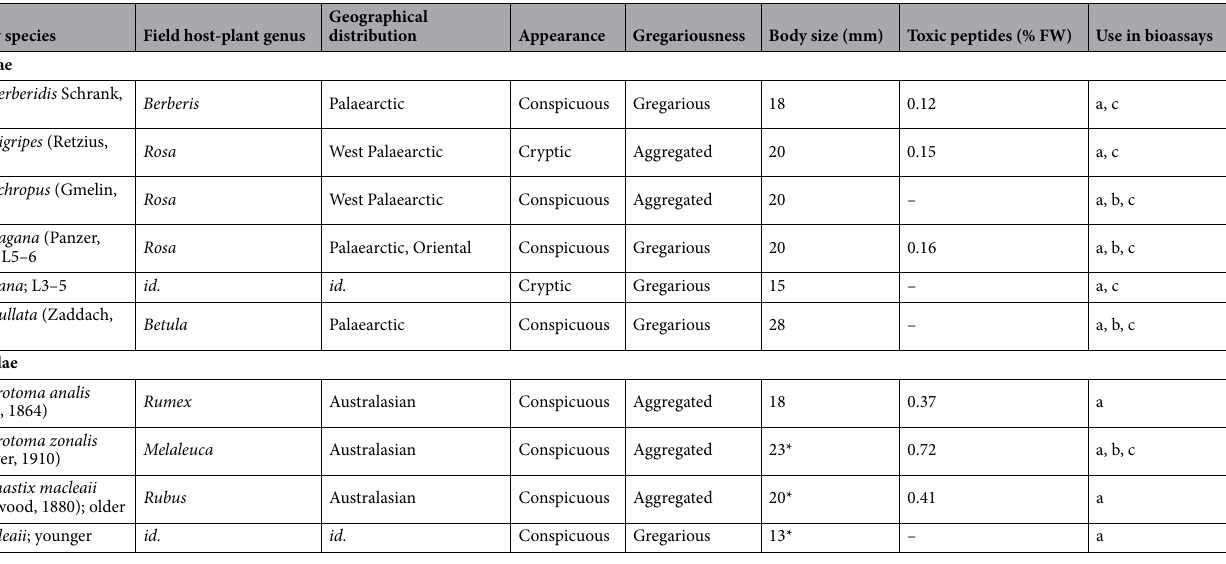
Table 1. Data about host plant, geographical distribution, larval appearance, gregariousness level, body size and toxin concentration of the sawfly species used in the study. Geographical distribution data are from the literature 30 ; A. ochropus has been introduced in the Nearctic. Appearance and gregariousness data are given for last-instar larvae, but bioassays with A. pagana and P. macleaii also included younger larvae. Gregariousness level: gregarious (i.e., larvae on one leaf or several adjacent leaves) or aggregated (i.e., generally less than